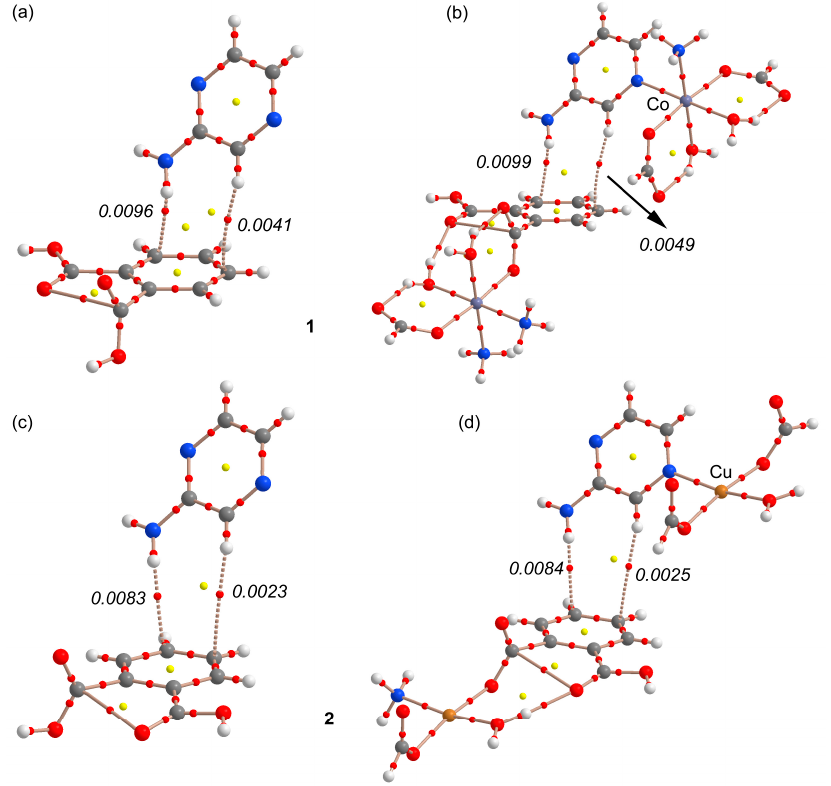
Figure 7. AIM analysis of two compounds 1 ( a , b ) and 2 ( c , d ). Red and yellow spheres represent bond and ring critical points, respectively. The bond paths connecting bond critical points are also represented by dashed lines. The values of ρ (r) at the bond CP are given in atomic units (a.u.). Since the charge density ρ (r) determined at the bond CP is a good measure of the strength of the interaction, the comparison of the ρ (r) values in the coordinated and uncoordinated compounds provides further insight into the influence of the metal coordination on the binding energy. The ρ (r) values are given in italics in Figure 7. The inspection of the results indicates that the values of ρ (r) are larger in compound 1 than in compound 2 , in good agreement with the energetic analysis commented above and confirming that the value of ρ (r) is good indicator of the interaction strength. Furthermore, the value at the bond CP that characterizes the N–H··· π is larger than that at the C–H··· π bond CP, suggesting that the N–H··· π interaction is stronger, in line with its shorter distance to the ring center.